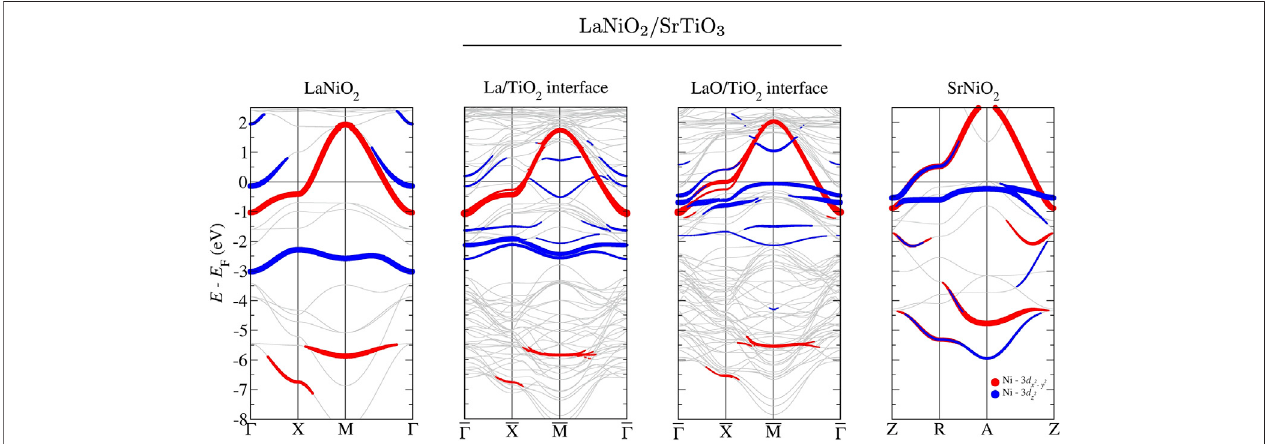
FIGURE 1 | Electronic band structure of the LaNiO 2 /SrTiO 3 heterostructure for different interfacial con fi gurations compared to bulk LaNiO 2 and SrNiO 2 with the same crystal structure and lattice parameters (the Γ -X-M- Γ and Z-R-A-Z paths fold to (cid:1) Γ - (cid:1) X - (cid:1) M - (cid:1) Γ ). The presence of interfacial apical oxygens introduces an effective hole doping that locally changes the occupation of the Ni-3 d states, so that oxidation state of the Ni atom increases from +1 towards +2. Adapted from [44].